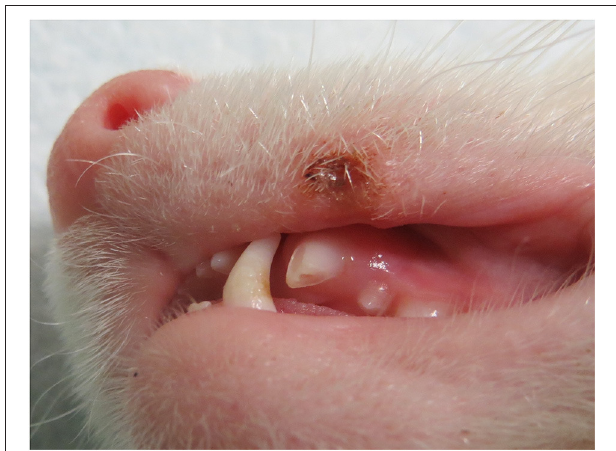
FIGURE 1 | Preoperative photograph of a domestic ferret affected by a complicated crown fracture of the left maxillary canine tooth, missing the majority of the crown, and a maxillary lip lesion caused by the healthy ipsilateral mandibular canine